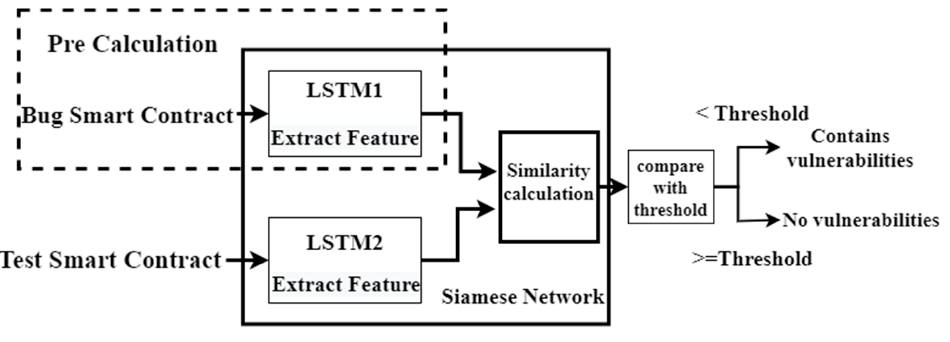
Figure 6. Vulnerability detection process.